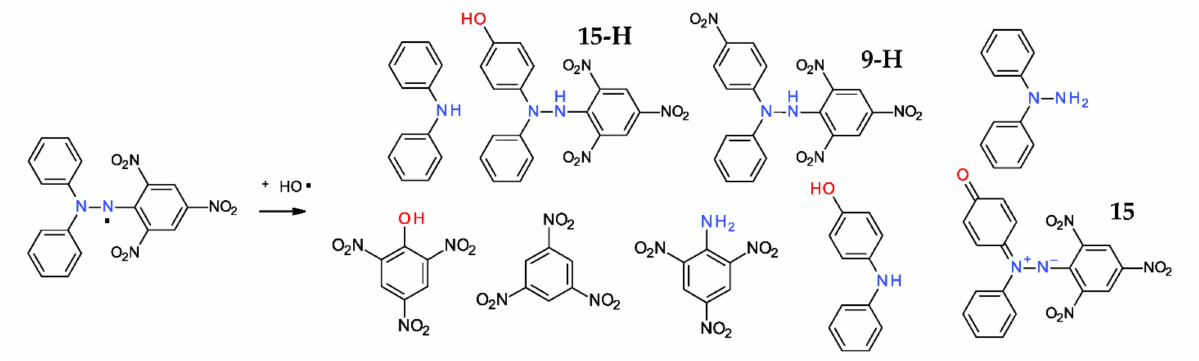
Figure 8. Reaction of DPPH · with hydroxyl free radical, showing a wide range of decomposition